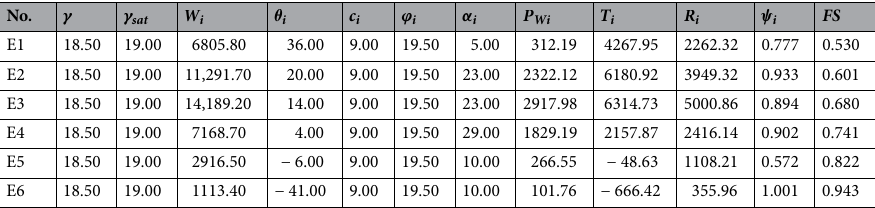
Table 4. Calculation results of the slope stability in cross section 3-3 ′ (considering continuous rainfall).